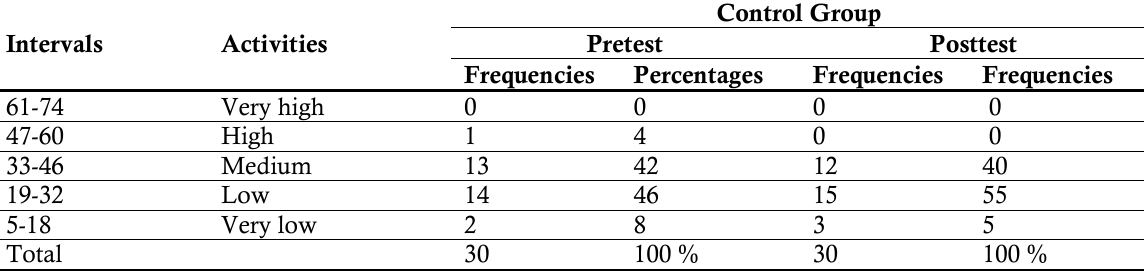
Table 3. Data on the social anxiety level of students according to pretest and posttest in the control group Intervals